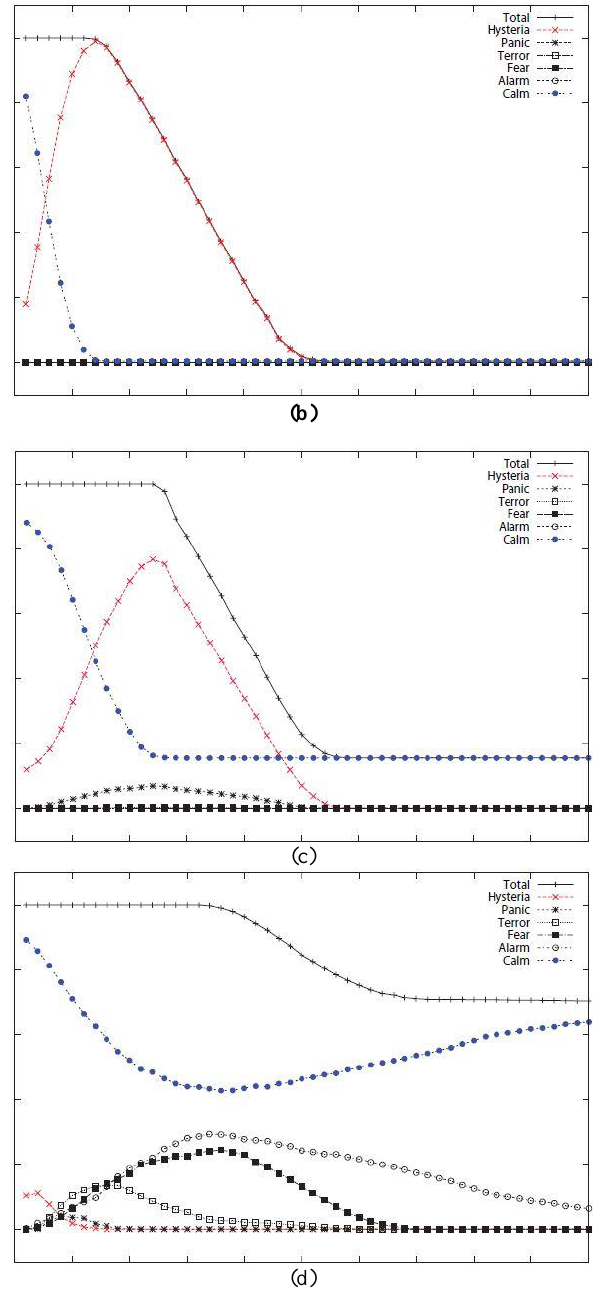
Figure 3. Agents exiting diagrams: a) scenario 1; b) scenario